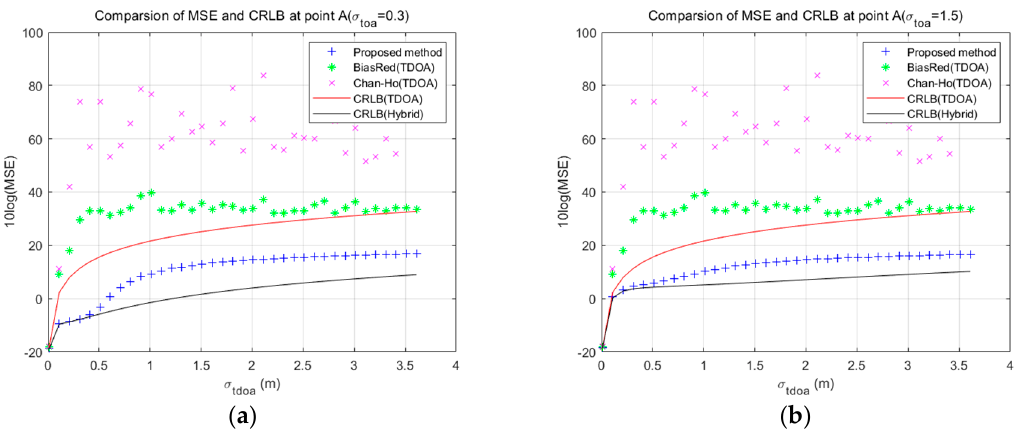
Figure 10. Accuracy of different positioning method at point A; ( a ) positioning error mean square error (MSE) when the standard deviation of TOA ranging error is 0.3 m; ( b ) positioning error MSE when the standard deviation of TOA ranging error is 1.5 m.